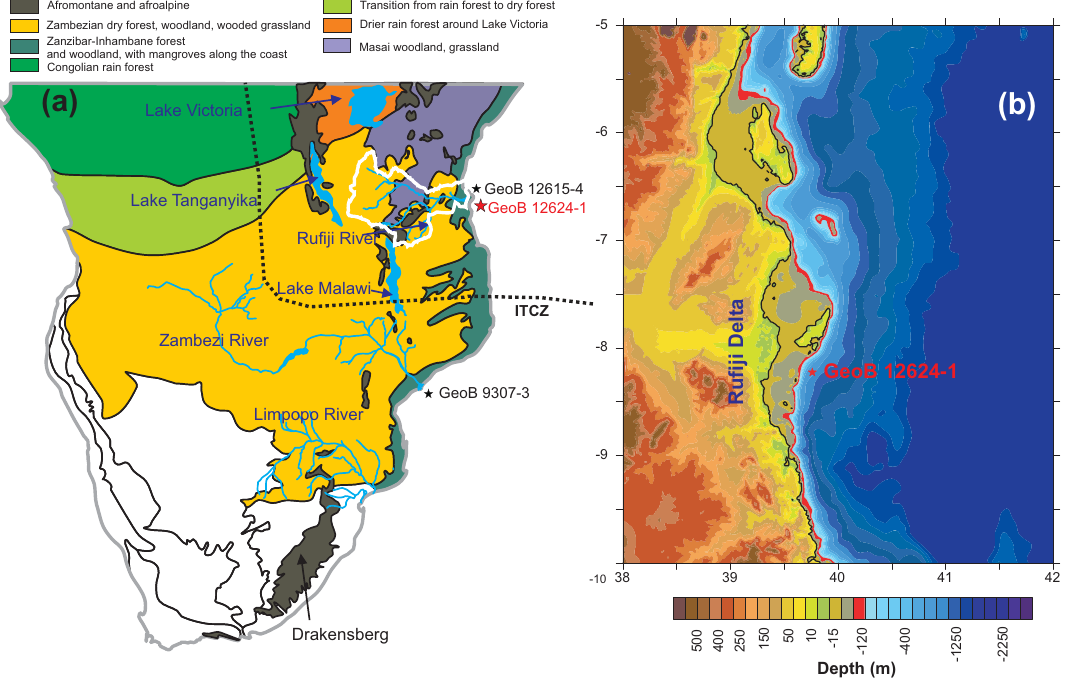
Figure 1. (a) Map of southern Africa showing the location of marine sediment core GeoB12624-1, simplified phytogeography and modern vegetation after White (1983) and approximate position of the ITCZ during austral summer (December, January, February). Indicated are the main course of the Rufiji River, Zambezi River and Limpopo River (blue lines), major lakes in the area and the outline of the Rufiji catchment in white. Other cores discussed in the text are also illustrated: GeoB9307-3 (Schefuß et al., 2011), GeoB12615-4 (Romahn et al., 2014). (b) Bathymetric map of the study area showing the location of marine sediment core GeoB12624-1 and the Rufiji